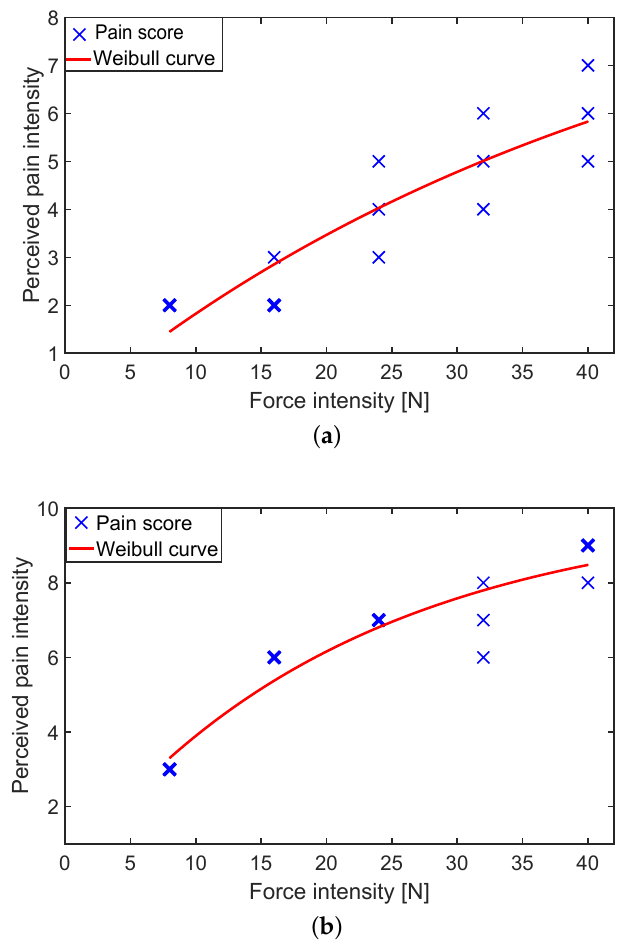
Figure 5. Typical sets of nociception scores in response to the randomized stimulation (5 levels of force × 3 sequences). ( a ) Forefinger. ( b ) Small